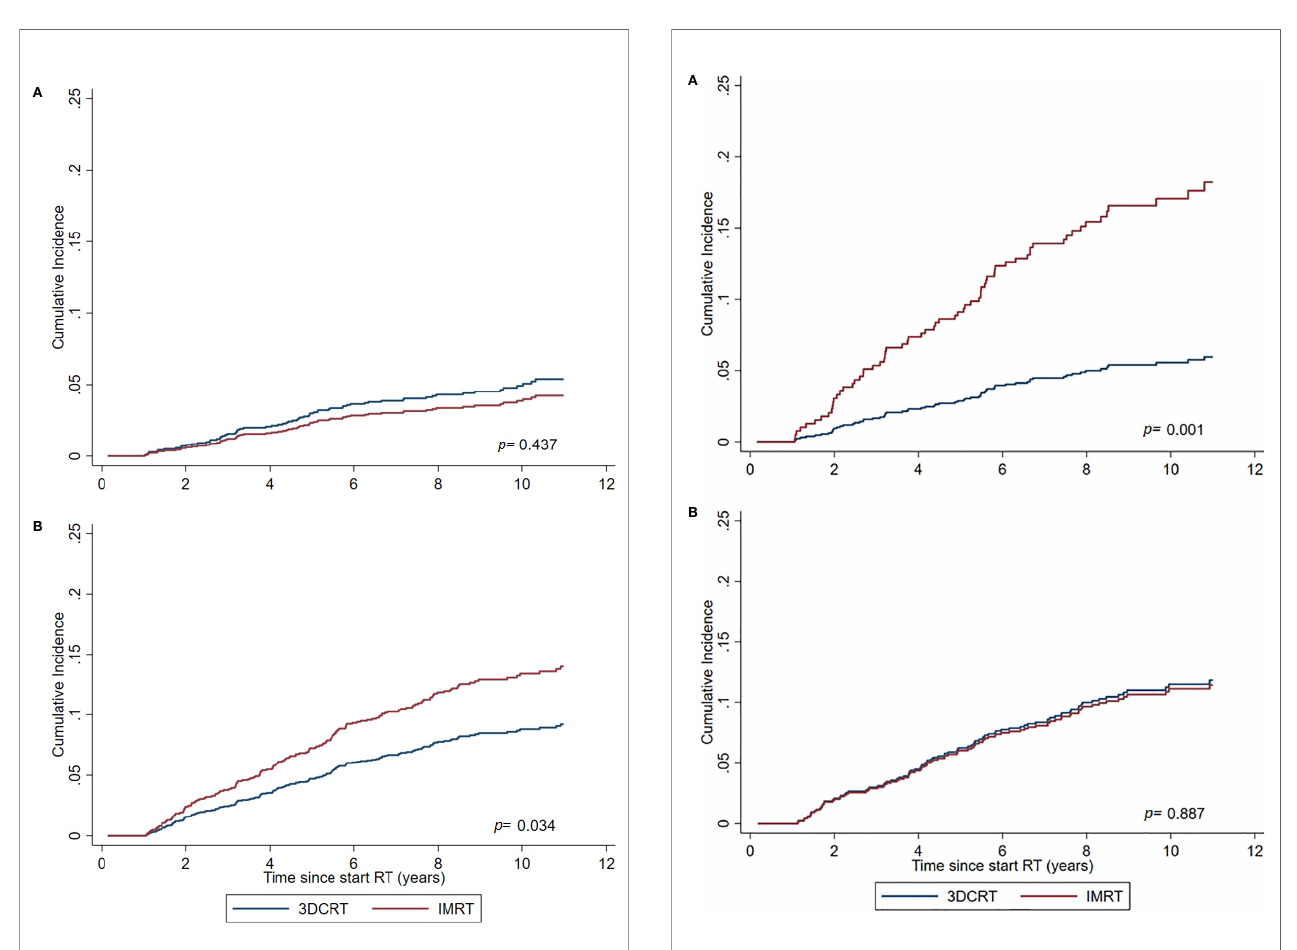
FIGURE 1 | Cumulative Incidence of solid SPCs for the IMRT and 3DCRT cohort, as estimated by the Fine and Gray model adjusted for calendar period and age. (A) For SPCs in the pelvic region. (B) For non-pelvic SPCs (primary endpoint). tumorsin5-yearssurvivors,theyobservednosigni fi cantdifferences